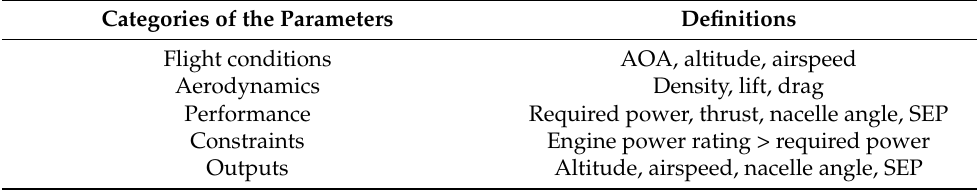
Table 2. Definitions of the parameters in the workflow of the calculation.